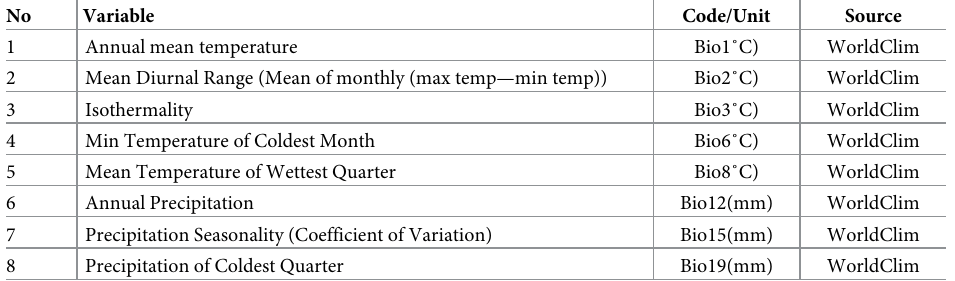
Table 1. Environmental variables used for modeling the potential distribution of Aedes spp. in the present